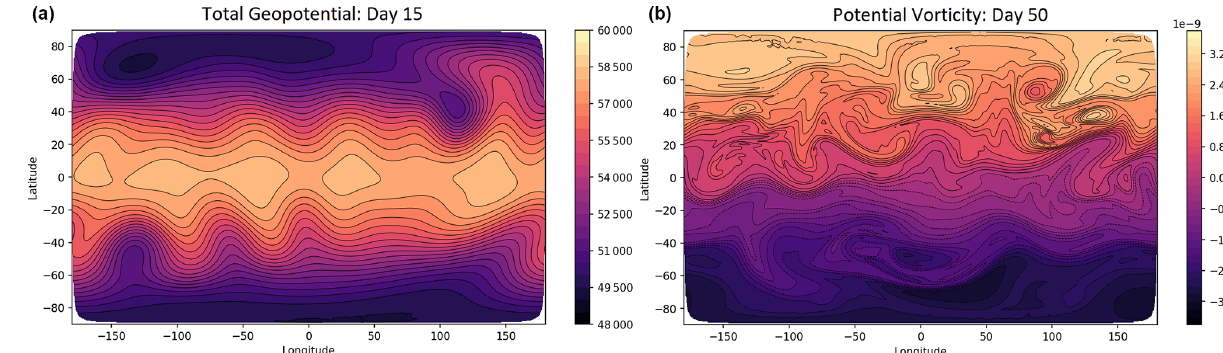
Figure 5. Results for the Williamson mountain test on the C96 grid. Panel (a) shows the total geopotential ( (cid:56) + (cid:56) s ) after 15d. Panel (b) shows the potential vorticity ( q ) after 50d.